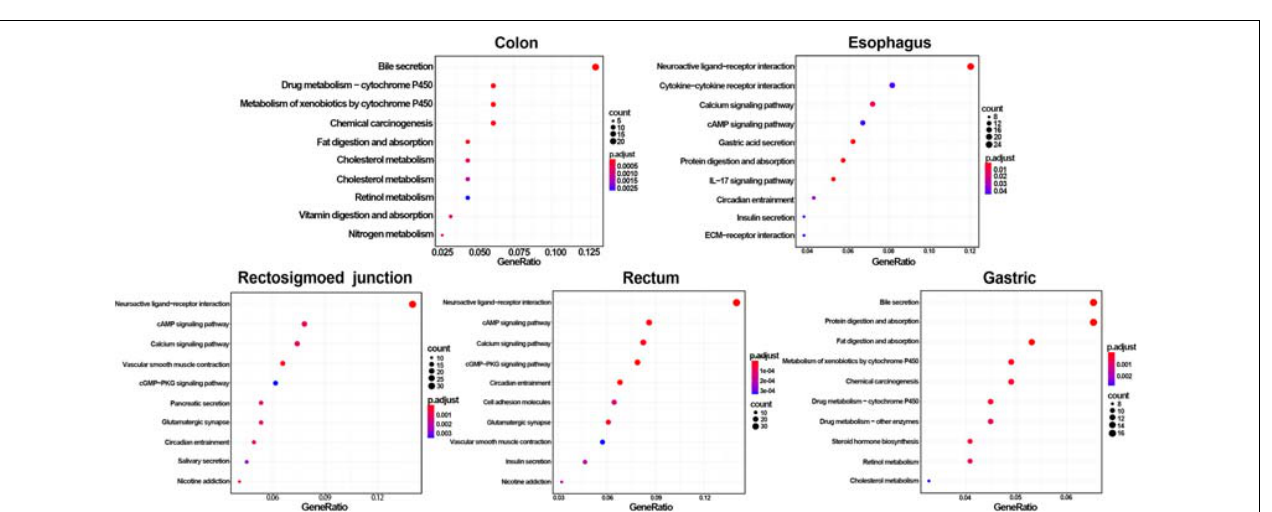
FIGURE 3 | Identification of differentially expressed RNAs and GO enrichment of DEmRNAs. (A) Bubble plot of GO enrichment for cancers. Green represents biological processes; red represents cellular components; and blue represents molecular functions. (B) The top 5 significantly enriched GO pathways and relevant genes.